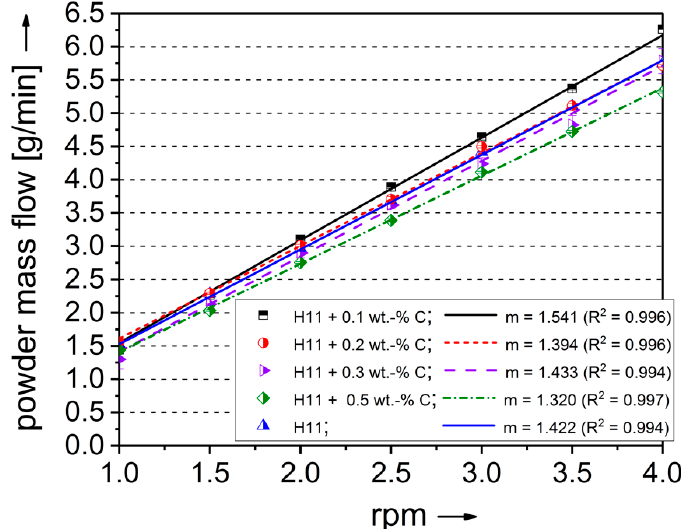
Figure 4. Experimentally determined powder mass flow of prepared powder mixture and pure AISI H11 powder with respect to rotation per minute (rpm) of the dosing plate.